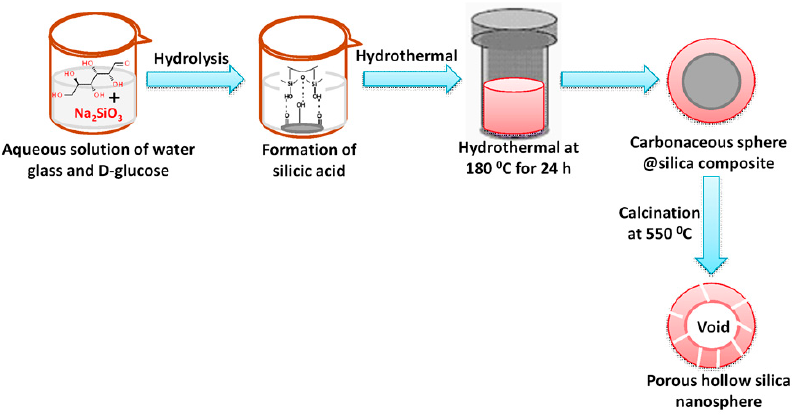
Figure 5. A simple strategy for synthesis of porous silica hollow sphere.